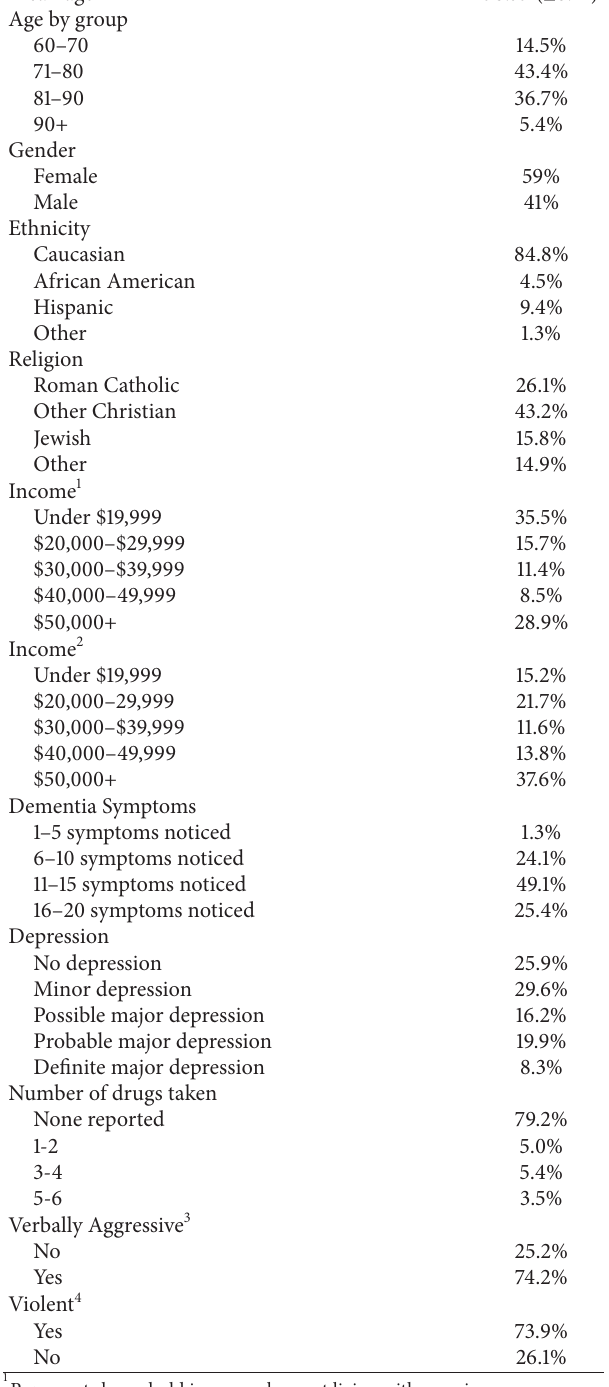
Table 2: Elder demographics ( 𝑁 = 76